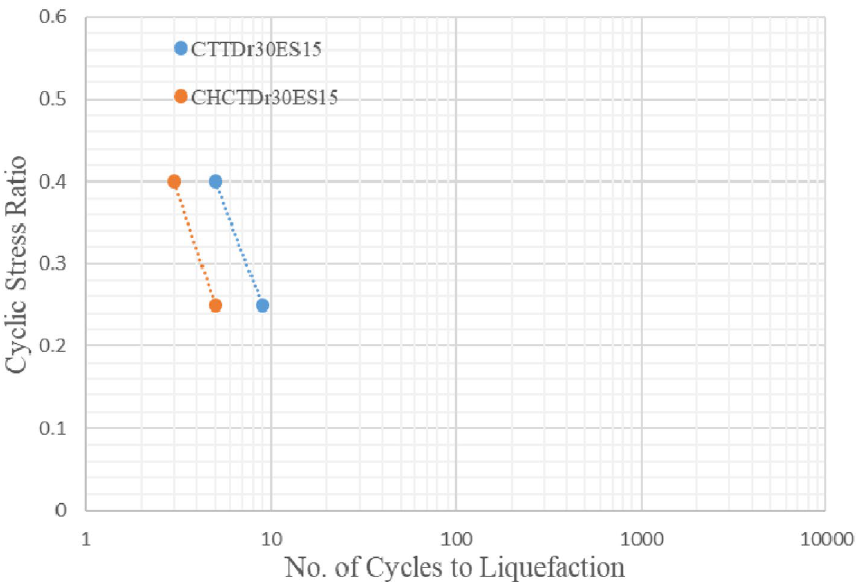
Figure 17. stress ratio vs number of cycles to liquefaction for samples (Dr 30%FC0ES15) in CTT and